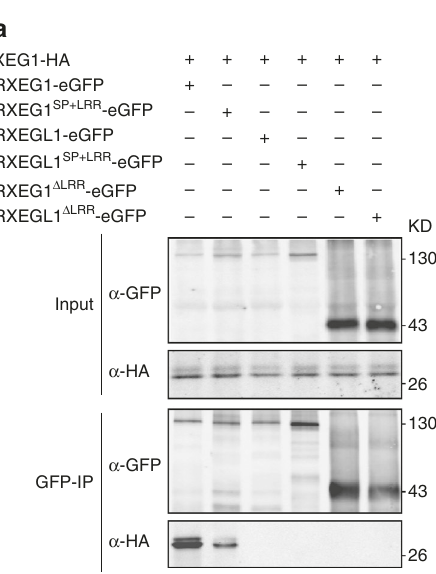
Fig. 5 XEG1 associates with RXEG1 via the LRR domain in planta. a The LRR domain but not the SP + eJM + TM + tail ( Δ LRR) TM domain of RXEG1 binds to XEG1 in planta. HA-tagged XEG1 was co-expressed with a GFP-tagged LRR or Δ LRR domain of RXEG1, RXEGL1, or RLP23. Protein association was analyzed by co-immunoprecipitation (Co-IP) and western blotting. b The LRR domain of RXEG1 binds to XEG1 in the apoplast. XEG1 was co-expressed with GFP-tagged RXEG1 SP+LRR , RXEGL1 SP+LRR , or RLP23 SP+LRR in N . benthamiana . Apoplastic fl uid was collected 2 dai and subjected to Co-IP and